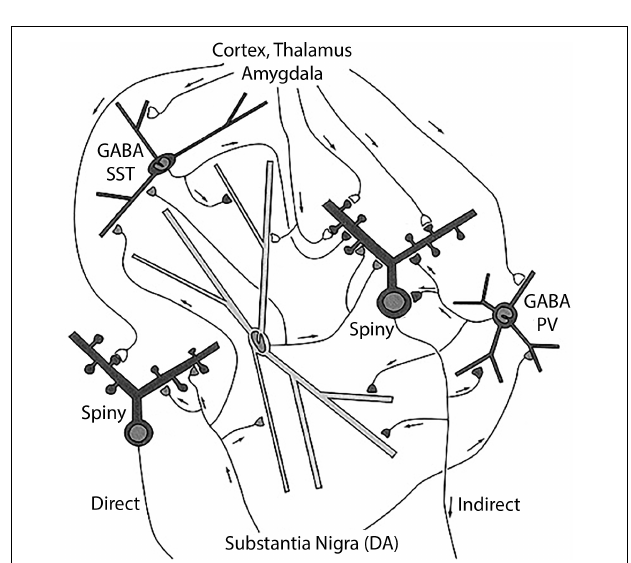
FIGURE 1 | Cross section of the lumbar spinal cord, showing in the ventral horn a principal neuron (alpha motor neuron: MN) with long motor axon to a distant target, a skeletal muscle; and interneurons with short axons that remain within their region of origin.